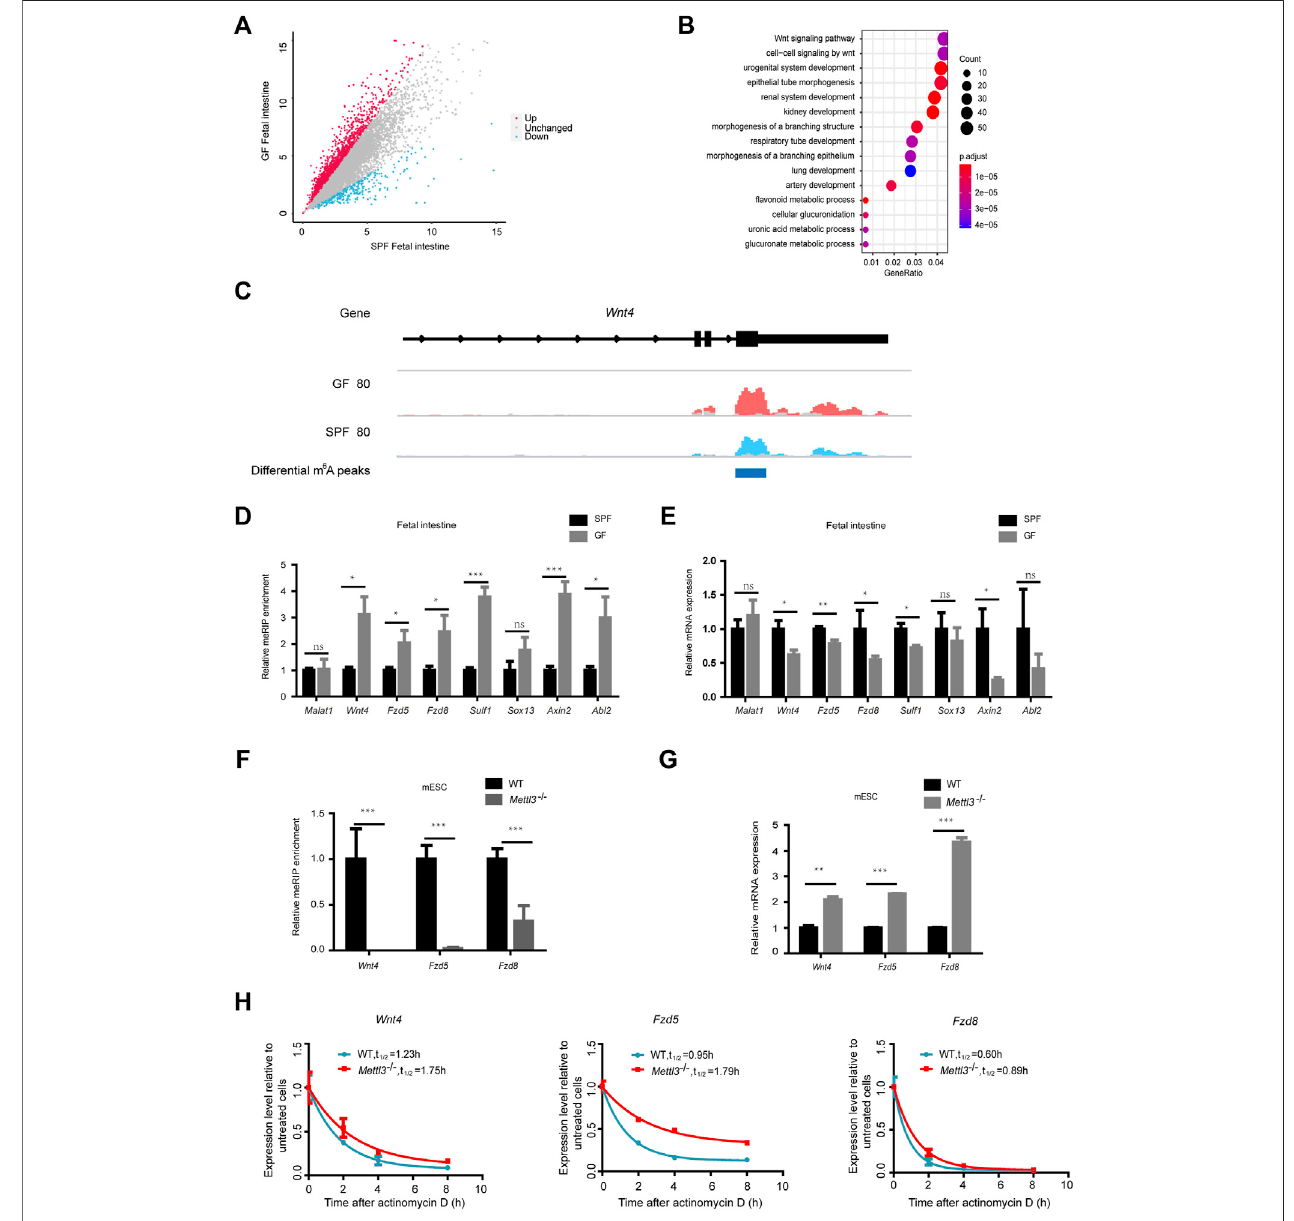
FIGURE 4 | Maternal microbiome regulates fetal intestinal m 6 A-modi fi ed genes in the Wnt signaling pathway. (A) Scatter diagram shows the number of differential m 6 A peaks in the GF fetal intestine. (B) Gene ontology-enrichment analysis of genes containing upregulated m 6 A peaks in the GF fetal intestine. (C) IGV shows the distribution of representative differential m 6 A peaks in Wnt4. GF IP, SPF IP, and input are shown in red, blue, and gray, respectively. (D) Validation of the relative m 6 A enrichmentsof Wnt4 , Fzd5 , Fzd8 , Sulf1 , Sox13 , Axin2 ,and Abl2 inSPFandGFfetalintestinesbym 6 A-immunoprecipitation(IP)-qPCR. (E) Validationoftherelative mRNA expression levels of Wnt4 , Fzd5 , Fzd8 , Sulf1 , Sox13 , Axin2 , and Abl2 in SPF and GF fetal intestines. (F) Validation ofthe relativem 6 Aenrichments of Wnt4 , Fzd5 , and Fzd8 intheWTand Mettl3 -/- mouseembryonicstemcelllineE14TG2abym 6 A-immunoprecipitation(IP)-qPCR. (G) ValidationoftherelativemRNAexpressionlevels of Wnt4 , Fzd5 , and Fzd8 in the WT and Mettl3 -/- mouse embryonic stem cell line E14TG2a. (H) Half-life (t 1/2 ) of Wnt4 , Fzd5 , and Fzd8 mRNA in the WT and Mettl3 -/- mouse embryonic stem cell line E14TG2a after actinomycin D treatment.